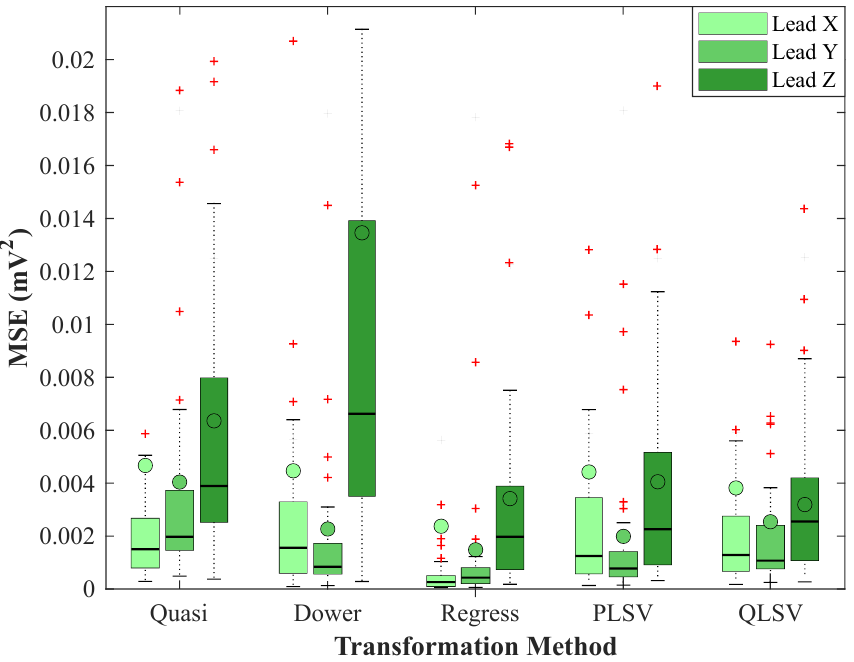
Figure 5. Box plot for comparison of the methods based on the mean squared error